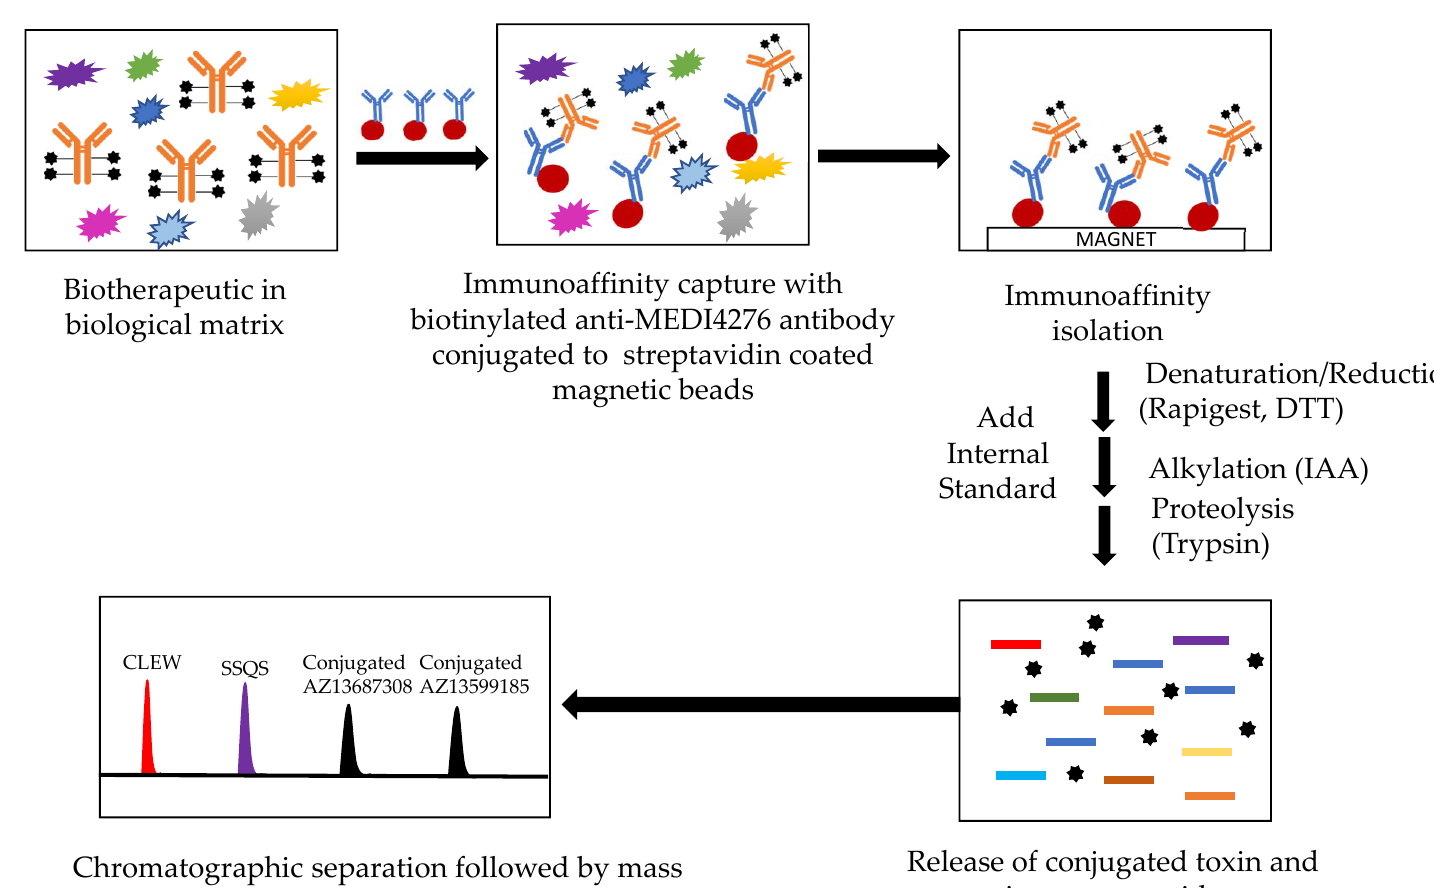
Figure 2. Hybrid LBA-LC-MS/MS design for simultaneous measurement of total antibody and conjugated payload (total ADC). CLEW = CLEWVAR; SSQS =